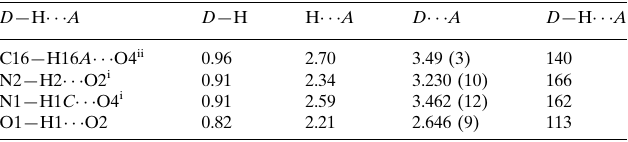
Hydrogen-bond geometry (A˚ , (cid:4)